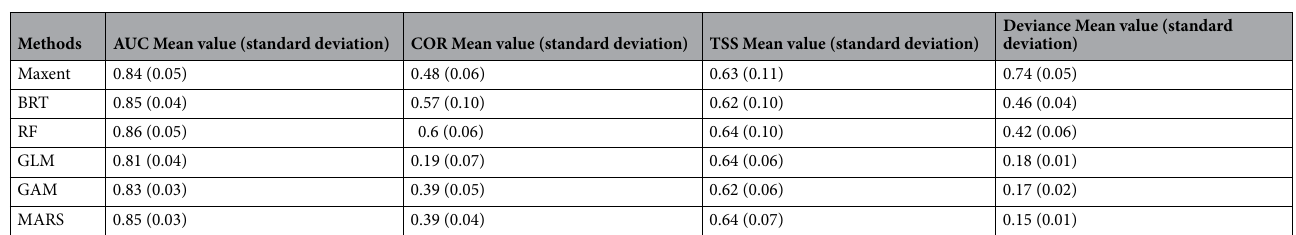
Table 1. Mean values of the statistics of model performance